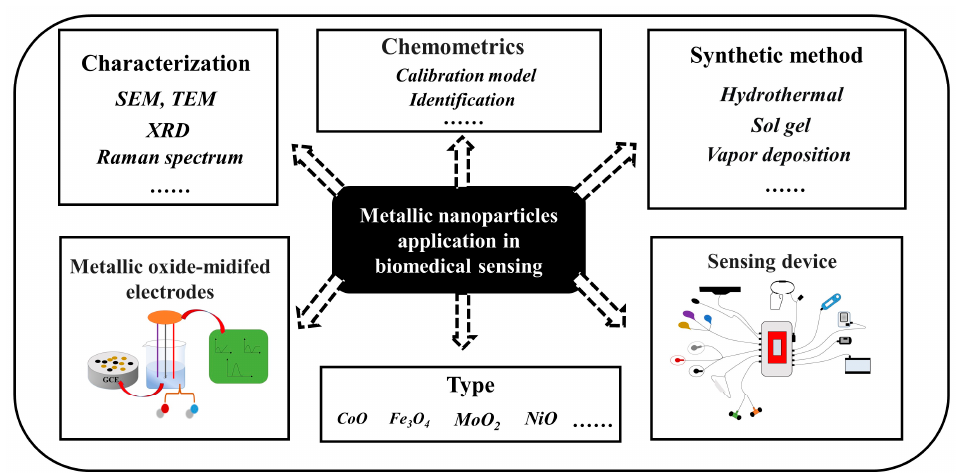
Figure 1. Research on the application of metallic nanomaterials for biomedical sensing.